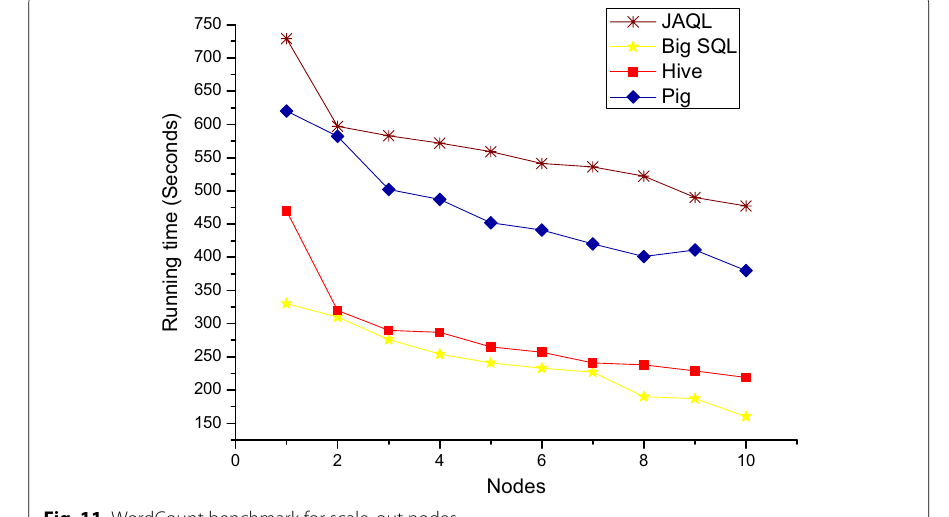
Fig. 11 WordCount benchmark for scale‑out nodes